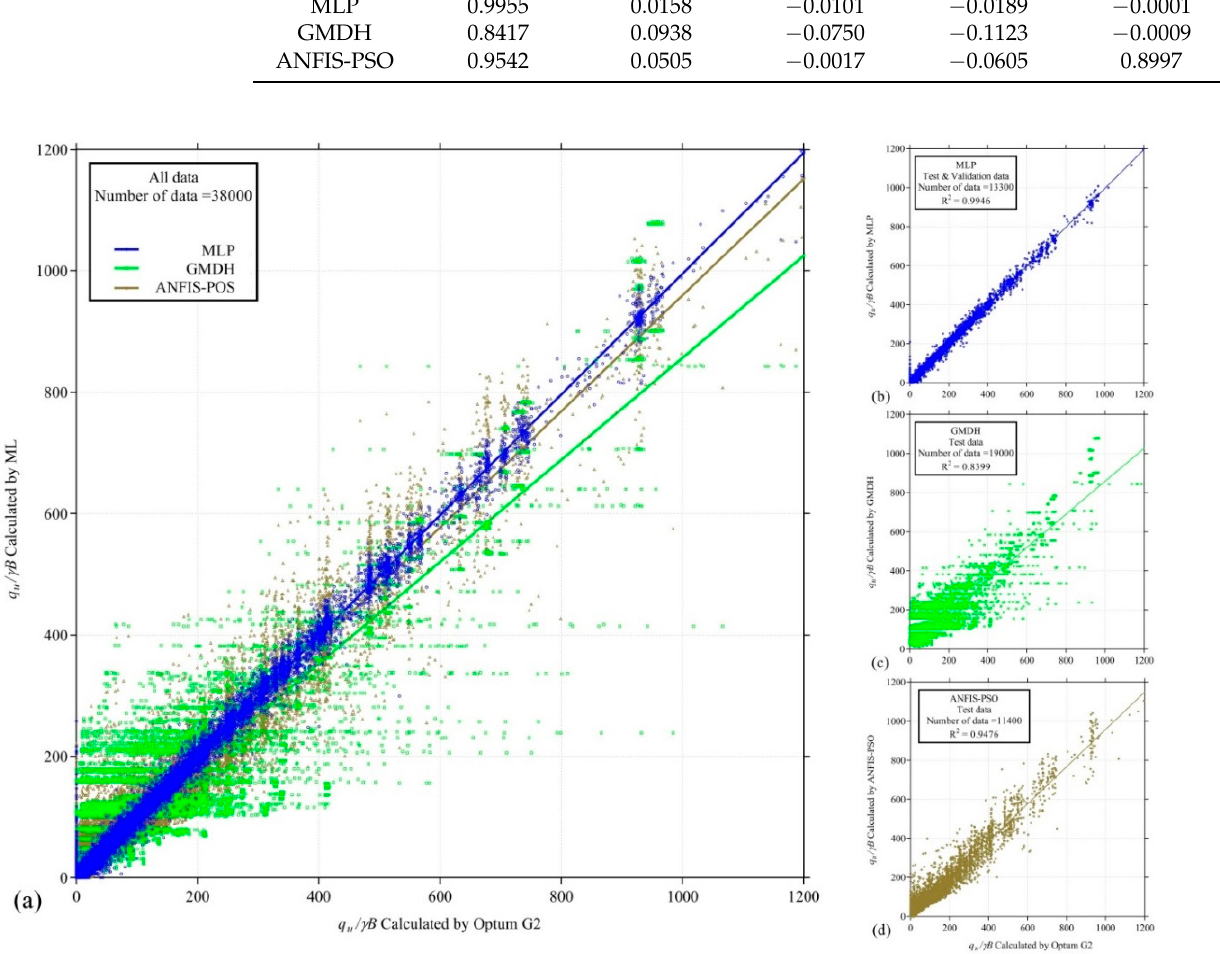
Figure 15. Performances of the ML algorithms: parity plots showing the ML output against the corresponding ground-truth numerical values for: ( a ) all the ML methods and regarding all the data; ( b ) MLP regarding test and validation data; ( c ) GMDH regarding test data; ( d ) ANFIS-PSO regarding test data.